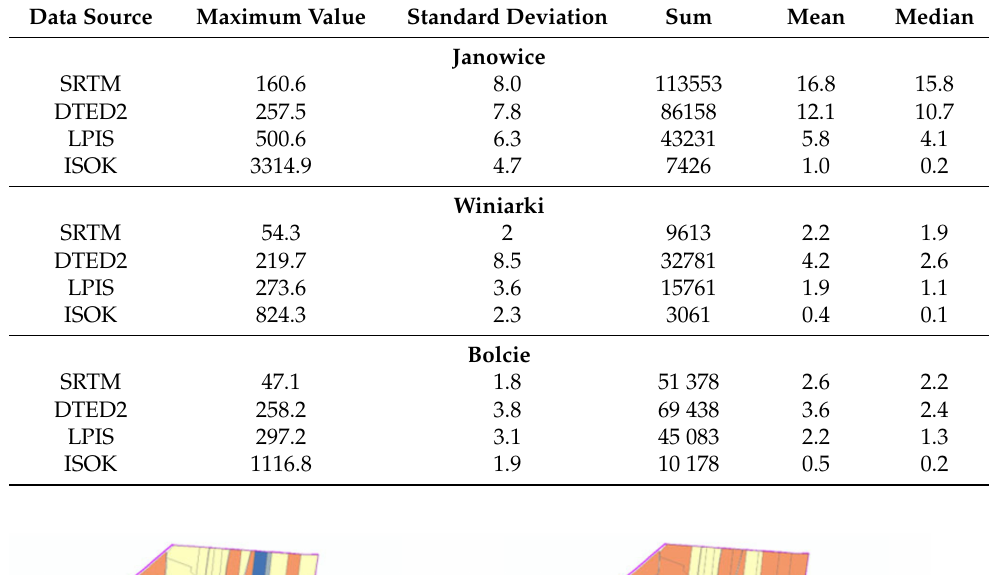
Table 13. Summary of the statistics of the total LS factor values (sum, standard deviation, mean, median and maximum values) for the agriculture plots in the 3 research areas.